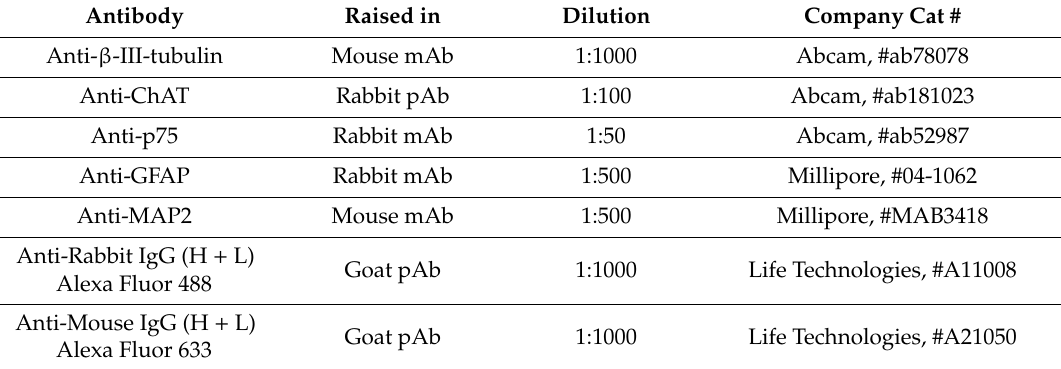
Table 2. List of antibodies used for